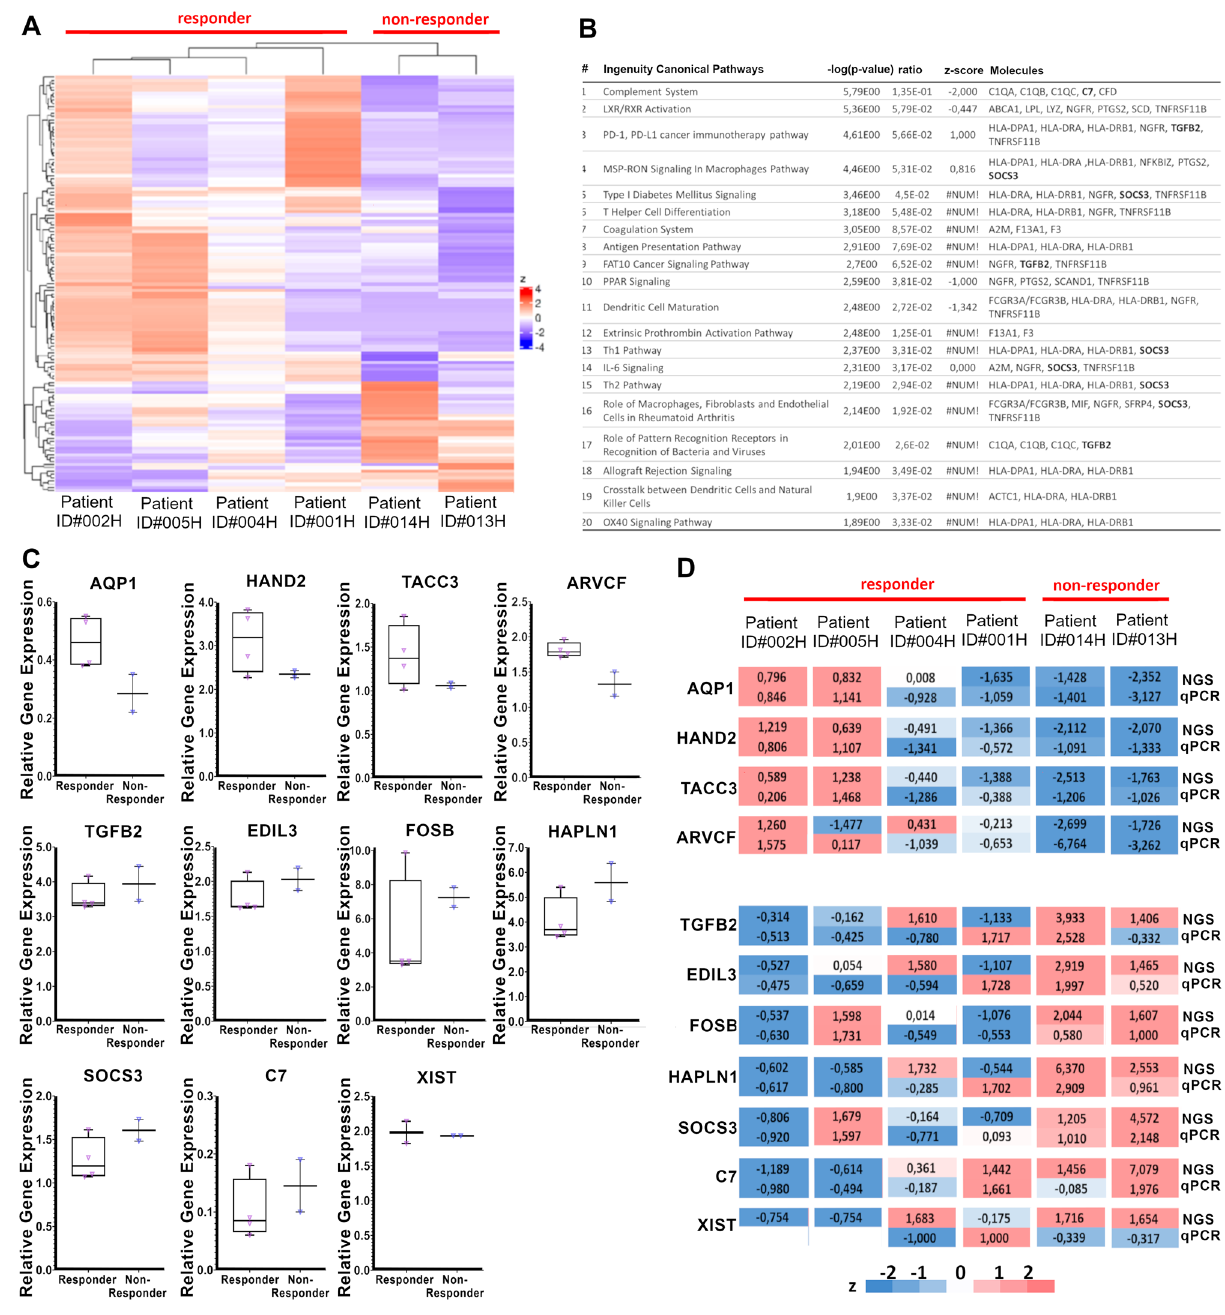
Figure 5. Osteoprogenitors from non-responders show differentially expressed pathways and gene patterns, validated by RT-qPCR analysis. ( A ) The raw hybridization data were normalized and subjected to trended dispersion calculation. After standardization (z) to mean = 0 and SD = 1, genes with differential expression (FDR p-value < 0.1) were subjected to hierarchical clustering heatmap analysis, revealing upregulated (red) and downregulated (blue) genes in the osteoprogenitors of individual patients, clearly separating the two non- responding patients (ID#013H and #014H). ( B ) The top 20 differentially regulated pathways in non-responders were identified by Ingenuity Pathways Analysis. Despite the lack of active regulation in some pathways (z-score of #NUM), all the top-regulated pathways (except for #9, FAT10 Cancer Signaling Pathway) were directly linked to T-helper cell differentiation, activation, and function. ( C ) RT-qPCR was performed on 11 selected genes. ( D ) To compare the RNA sequencing data (NGS) and RT-qPCR gene expression analysis (qPCR) between the two groups, we used standardization(z) to mean = 0 and SD = 1 to visualize the upregulated (red) and downregulated (blue)